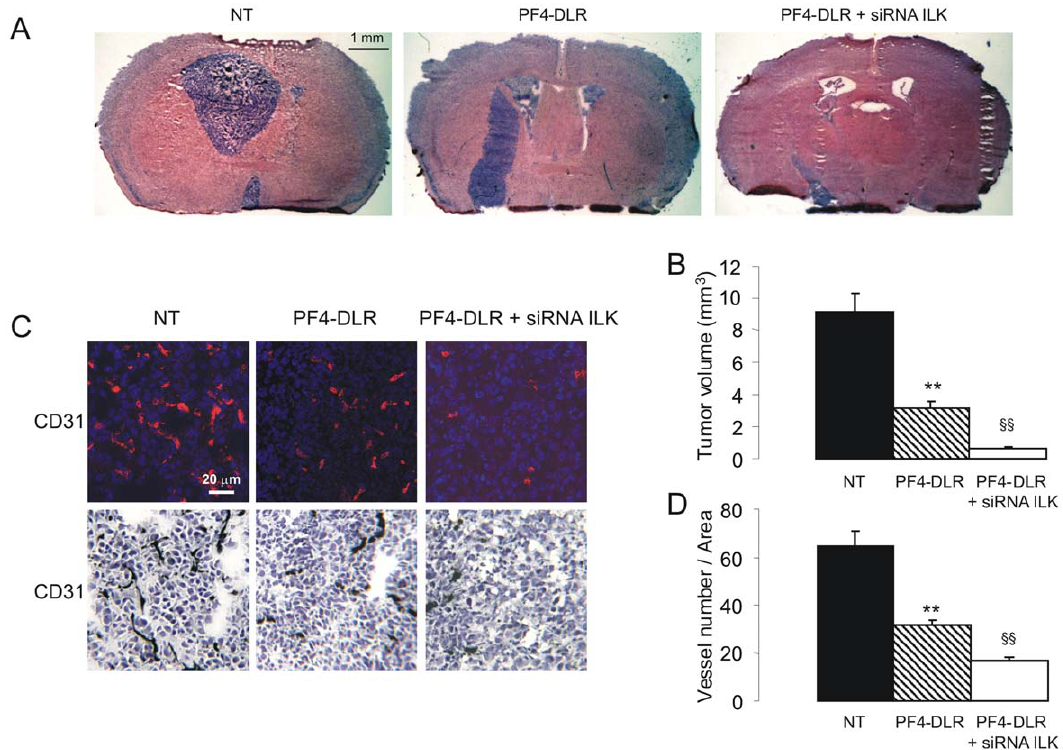
Figure 5. Effect of PF4-DLR + siRNA ILK1 treatment on glioblastomas development in vivo. A) Representative hematoxylin-eosin stained histological sections of brains from mice xenografted with U87-MG and treated or not (NT) with PF4-DLR or PF4-DLR plus ILK1 siRNA (PF4-DLR + siRNA ILK1). Scale bar =1 mm. B) Tumor volumes were quantified from six different brains per group, and the results expressed as mean values 6 SEM. Significant differences between groups are indicated (one-way ANOVA followed by Tukey’s post hoc test, **p , 0.05 PF4-DLR versus NT; 11 p , 0.05 PF4-DLR + siRNA ILK1 versus PF4-DLR). C) Representative image of vessel staining (blue: DAPI, red: anti CD31) and immunohistochemestry of CD31. Scale bar 20 m m. D) Vessels were counted in the tumor area and were found significantly reduced in animals treated with PF4-DLR or PF4-DLR plus ILK1 siRNA (PF4-DLR + siRNA ILK1). Significant differences between groups are indicated (one-way ANOVA followed by Tukey’s post hoc test **p , 0.05 PF4-DLR versus NT; 11 p , 0.05 PF4-DLR + siRNA ILK1 versus